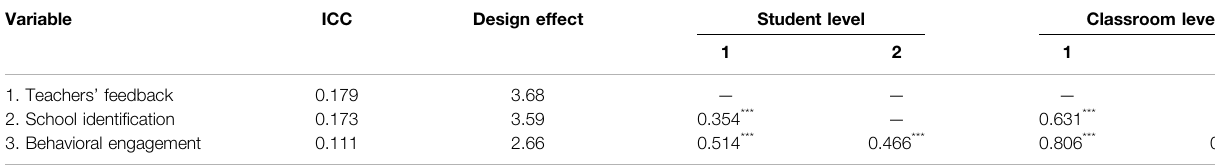
TABLE 2 | Classroom Level Intraclass Correlations (ICC) and intercorrelations at students and classroom level. Variable